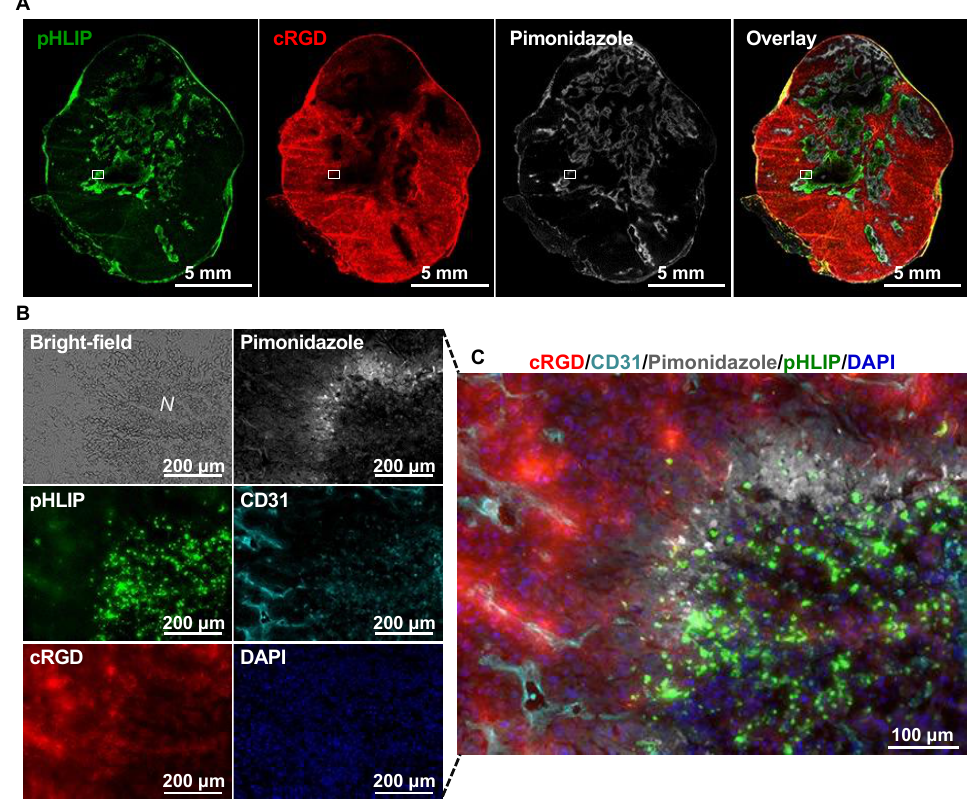
Figure 9. Spatial relationship of the ITD of pHLIP with the cRGD peptide-based probe, Cy5.5- RaftRGD. Tumors were examined at 4 h post-injection of 5 nmol IR800-pHLIP and 10 nmol Cy5.5- RaftRGD. ( A ) Near-infrared fluorescence (NIRF) images of the distribution of pHLIP (green), cRGD (red), and pimonidazole-stained hypoxia (white) on the representative whole section of a U87MG tumor. ( B ) Enlarged views of the same ROI (rectangles indicated in ( A )) and the corresponding images of bright-field, CD31-stained microvessels (aqua), and DAPI-stained nuclei (blue). N , necrotic region. ( C ) Highly magnified fluorescence overlay.